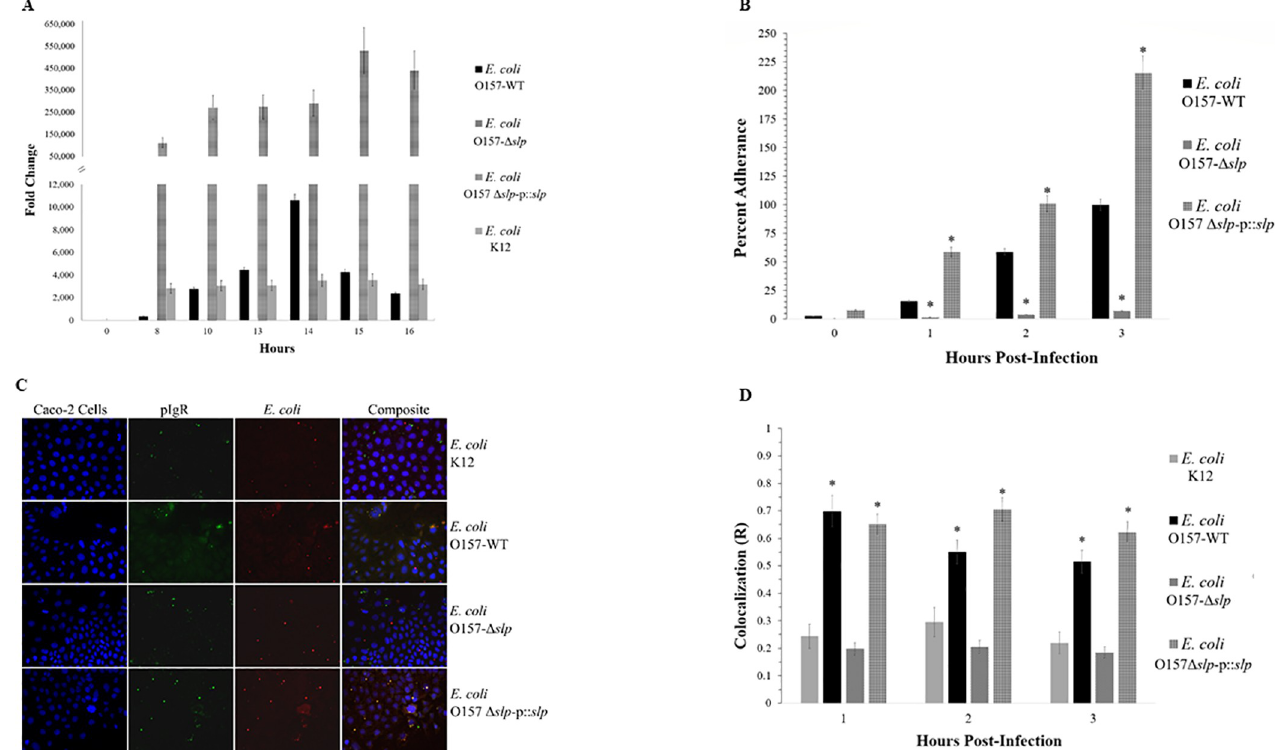
Fig 4. Relative slp gene expression, colocalization, and adherence in E . coli strains. (A) Relative gene expression of slp over time in LB broth culture as measured by qPCR, when compared to expression at time 0. (B) Quantitative adherence of E . coli strains to Caco-2 cells over time, relative to the maximum number of adhered wild-type bacteria (100% adherence is wild-type at 3 h post-infection). Statistical significance, shown as � , is as compared to the O157-WT strain at the same time points. (C) Fluorescence and (D) colocalization of pIgR with E . coli O157-WT, O157- Δ slp , and O157 Δ slp -p: slp .Statistical significance, shown as � , is as compared to the E . coli K12 control at the same time points. P -values < 0.05 were considered